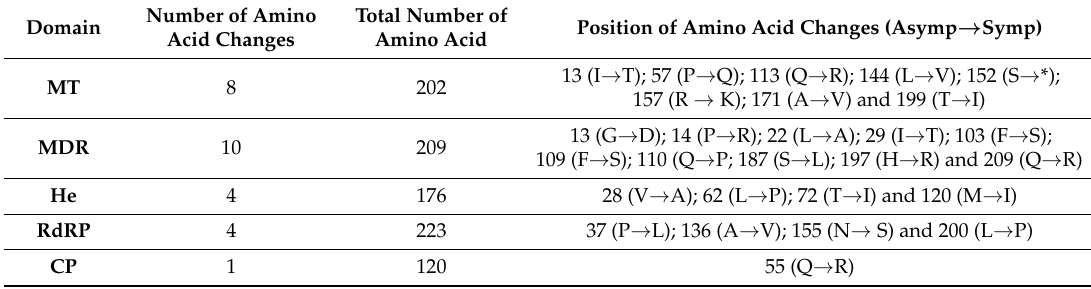
Table 7. Amino acid changes in five CSDaV genomic regions in isolates obtained from symptomatic citrus plants compared to isolates obtained from asymptomatic citrus